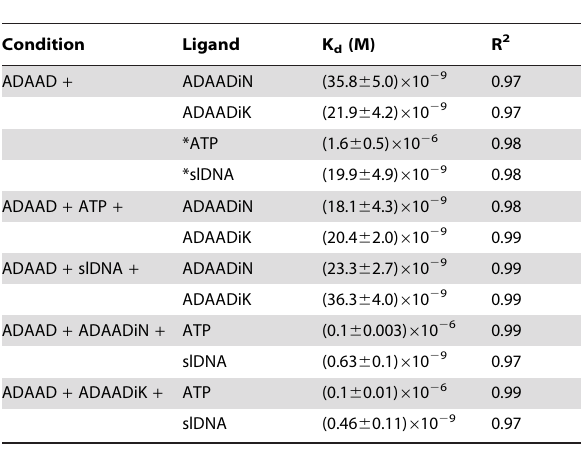
Table 1. Interaction of ADAADiN and ADAADiK with ADAAD in absence and presence of ATP and